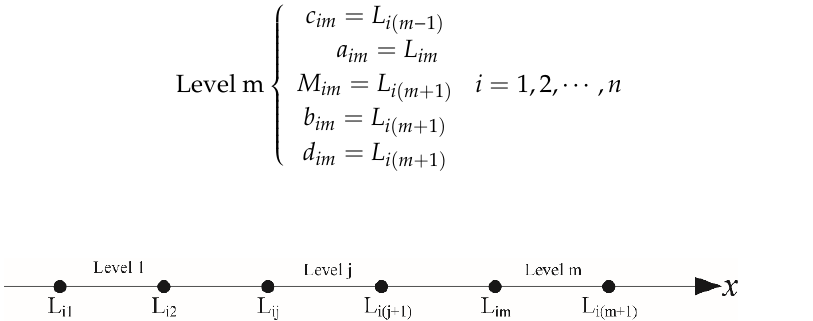
Figure 2. The boundary eigenvalues of index i corresponding to m levels.